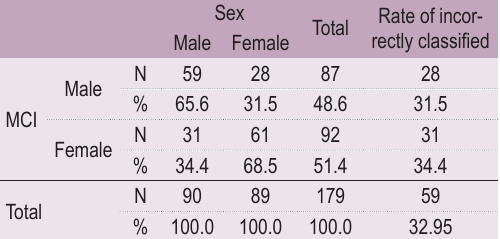
TABLE 3. Rate of incorrectly classi fi ed individuals on grounds of Mandibular Canine Index